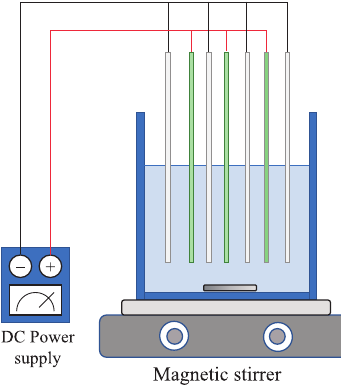
Fig. 2 Monopolar arrangement of an electrochemical cell for scaling up of magnetite nanoparticles